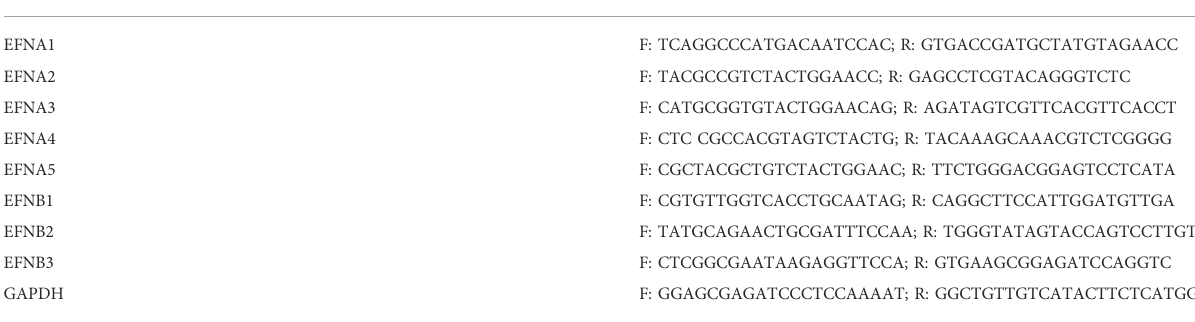
TABLE 1 Primers for RT-qPCR analysis targeting ephrin